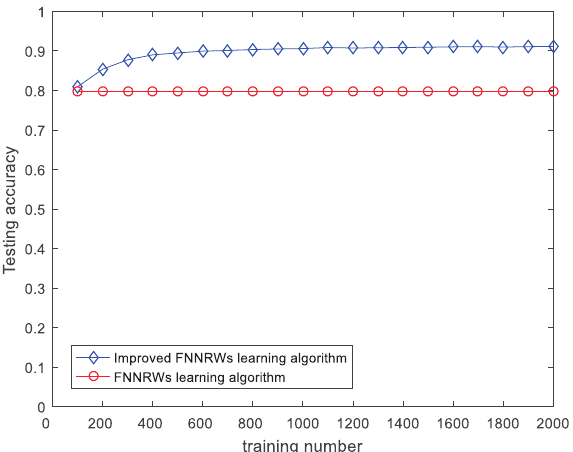
Figure 5. Comparison of the learning algorithms used by the FNNRW for training accuracy. The ac- curacy of the improved FNNRW method is superior to the FNNRW algorithm in the training dataset in terms of different training durations.